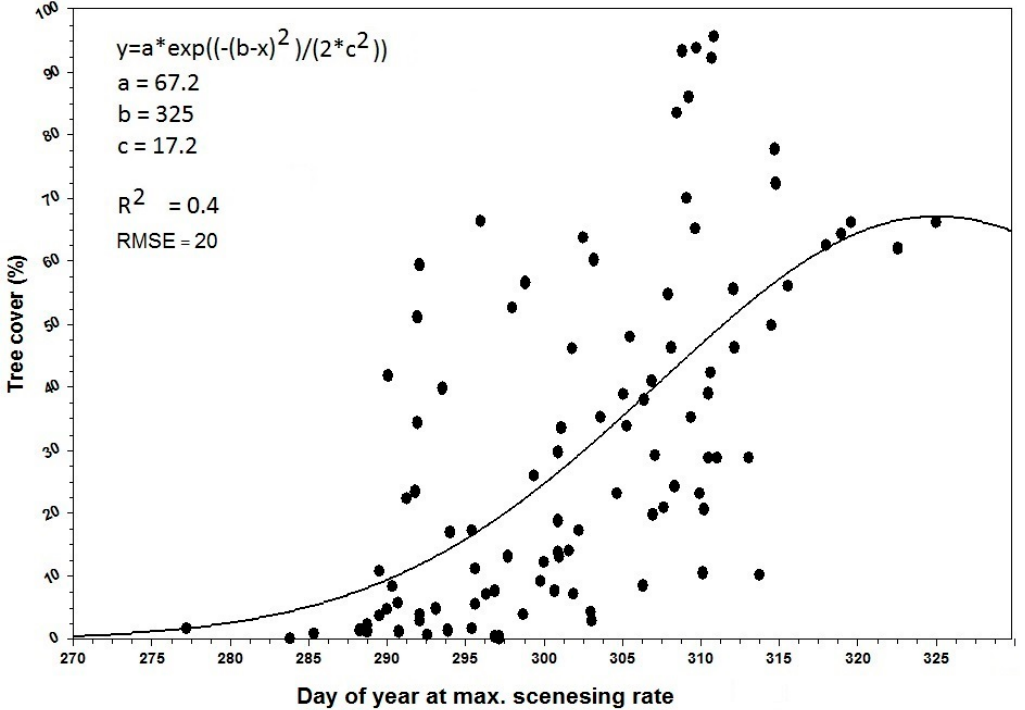
Figure 9. Model used to map tree cover (%) in the study area.